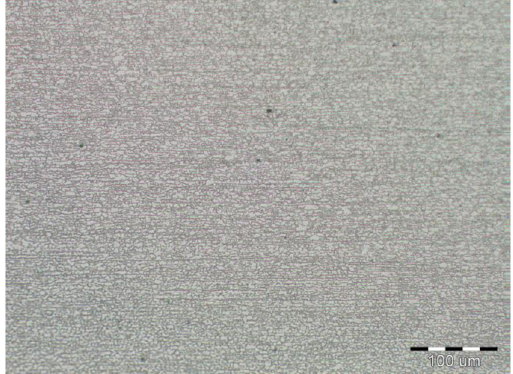
Figure 16. Fine-grained multiphase microstructure of TRIP base material.